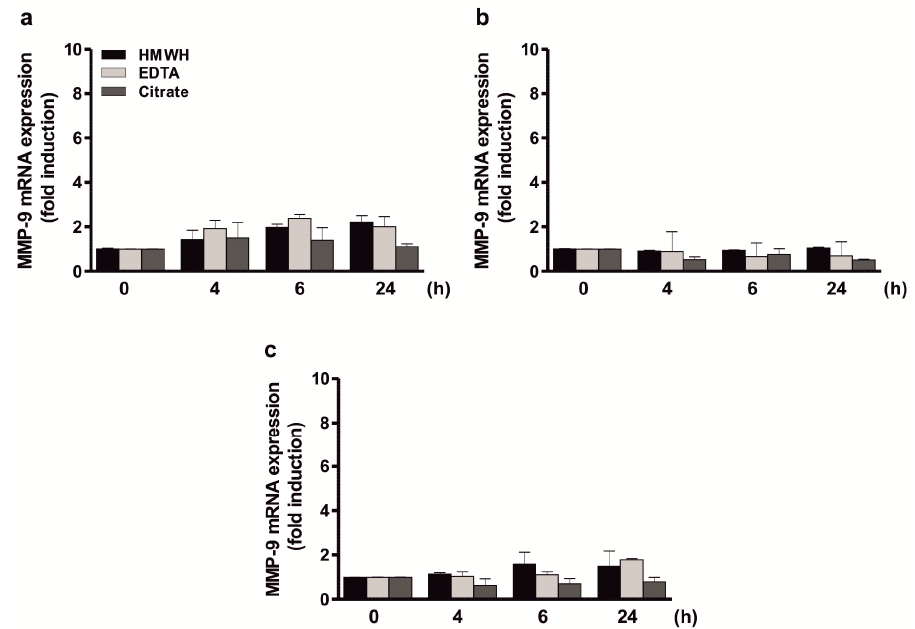
Figure 1. No significant induction of MMP-9 expression by HMWH, EDTA, or citrate in individual cell line cultures of THP-1, Jurkat, and HT cells. 2 × 10 5 THP-1 ( a ), Jurkat ( b ), or HT cells ( c ) per well were starved overnight and then stimulated with 50 IU/well HMWH, 3.2 mg/well EDTA, or 220 µL/well citrate up to 24 h. MMP-9 mRNA expression was determined using qPCR (QuantiTect Custom Assay; housekeeping gene: GAPDH); mean ± SD, n = 3.